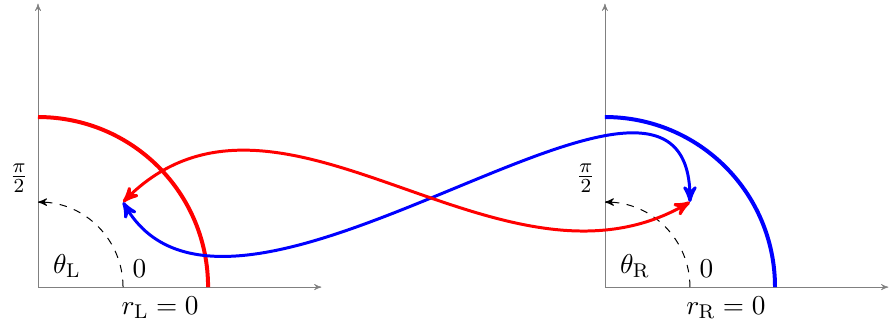
Figure 17 . Two entangled distributions of giant gravitons located at r L = 0 and r R = 0, spread over two di(cid:11)erent spheres along (cid:18) L and (cid:18) R connected through the correlations encoded in the phase space formulation of their joint quantum mechanical